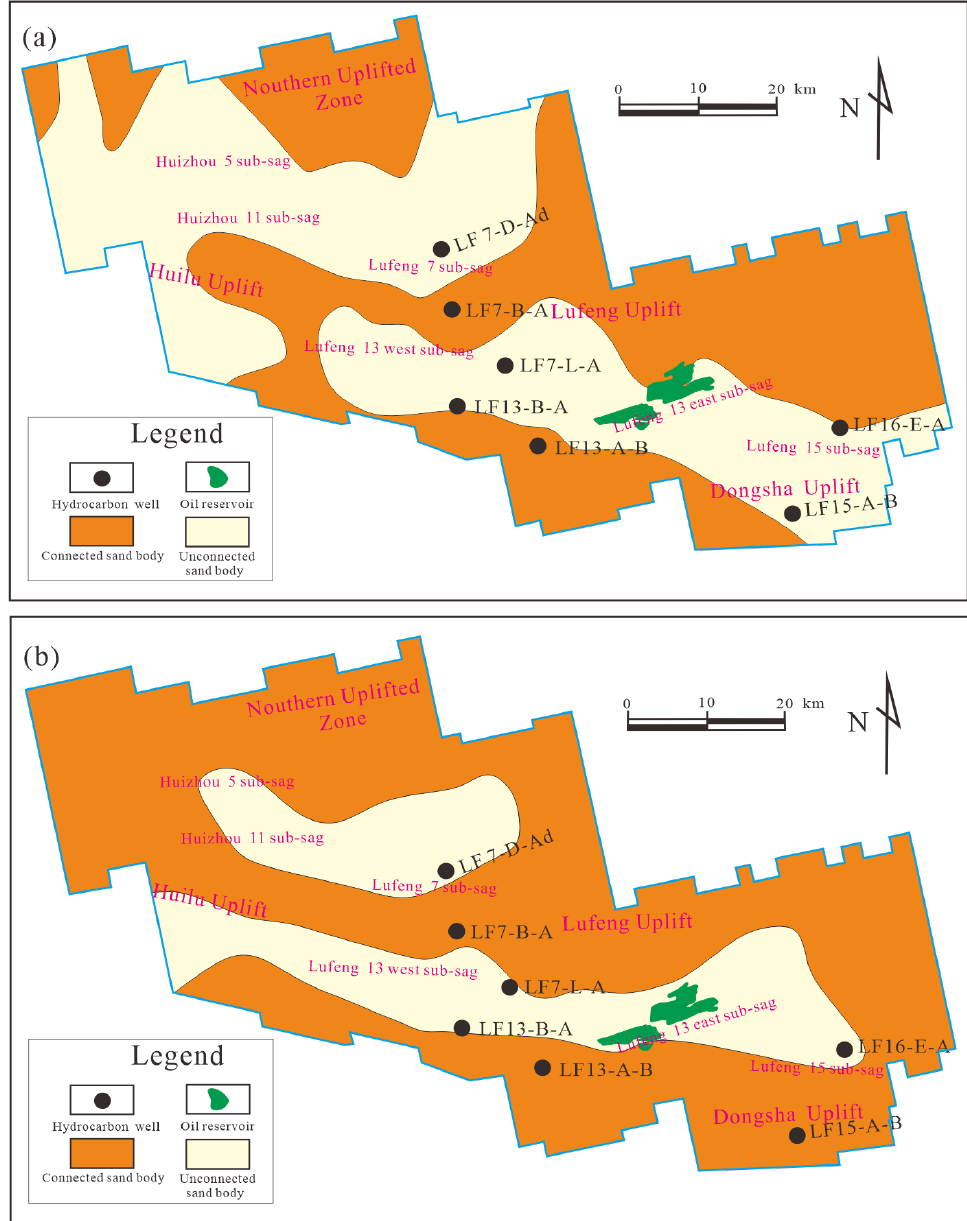
Figure 14. Plane distribution characteristics of the connected sand bodies in Lufeng sag; ( a ) the upper WC; ( b ) the lower WC.